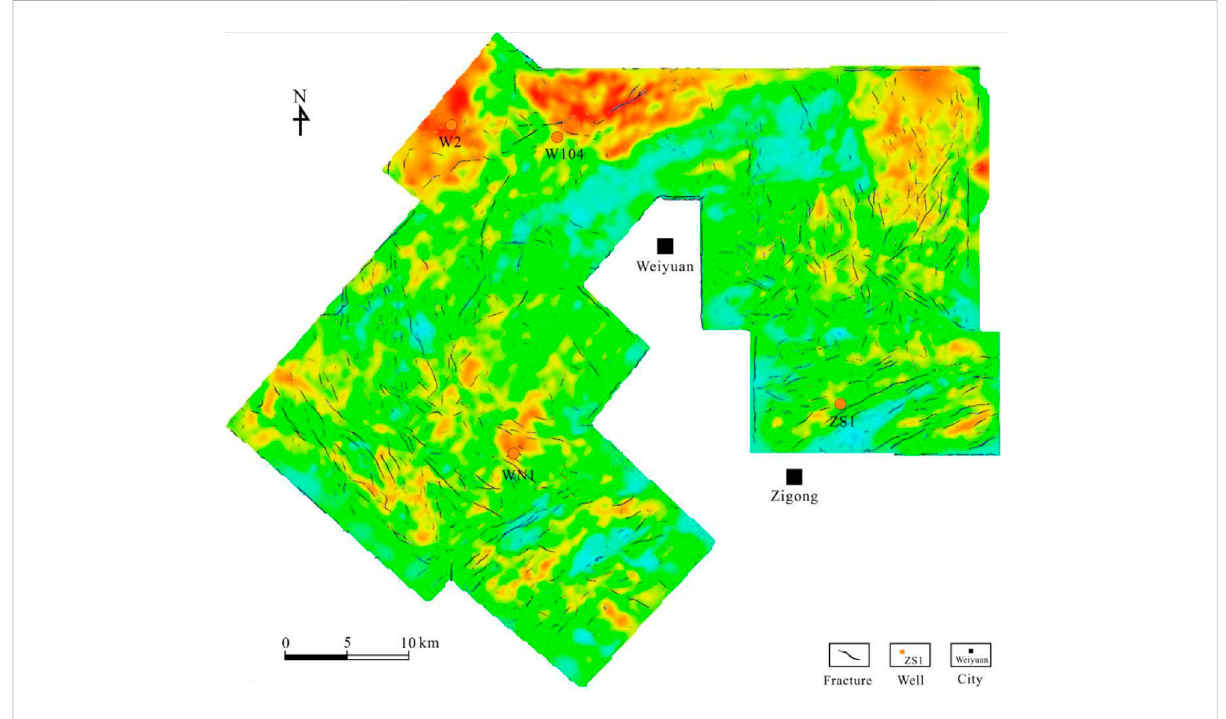
FIGURE 9 Distribution map of superimposed fractures in Xixiangchi Formation in Weiyuan